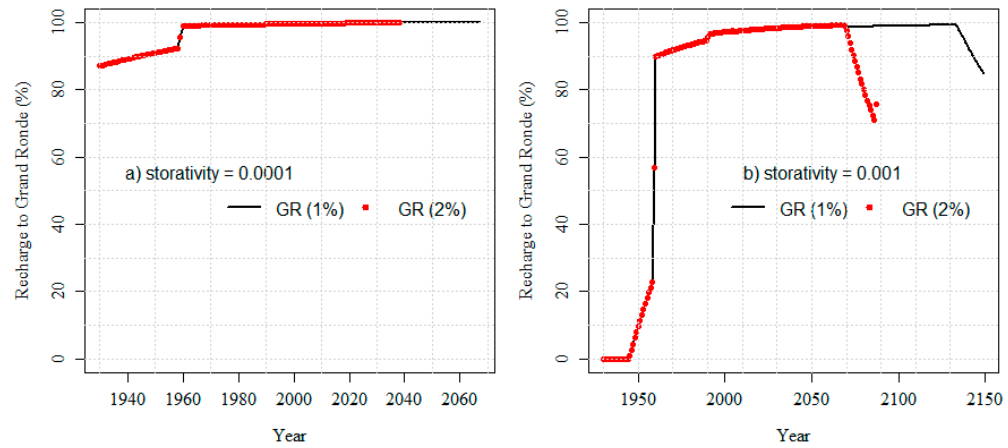
Figure 7. Simulation result of percent contribution of WP to GR as recharge.